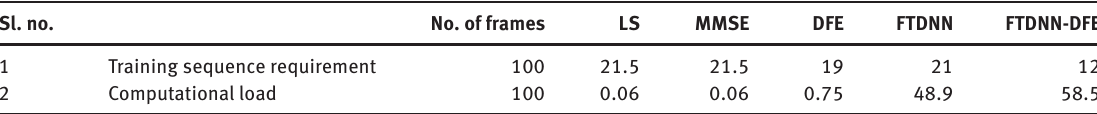
Table 3: Comparison of Training Sequence Requirement for a Frame Length 100 (in Average %) and Computational Load Com- plexity (in